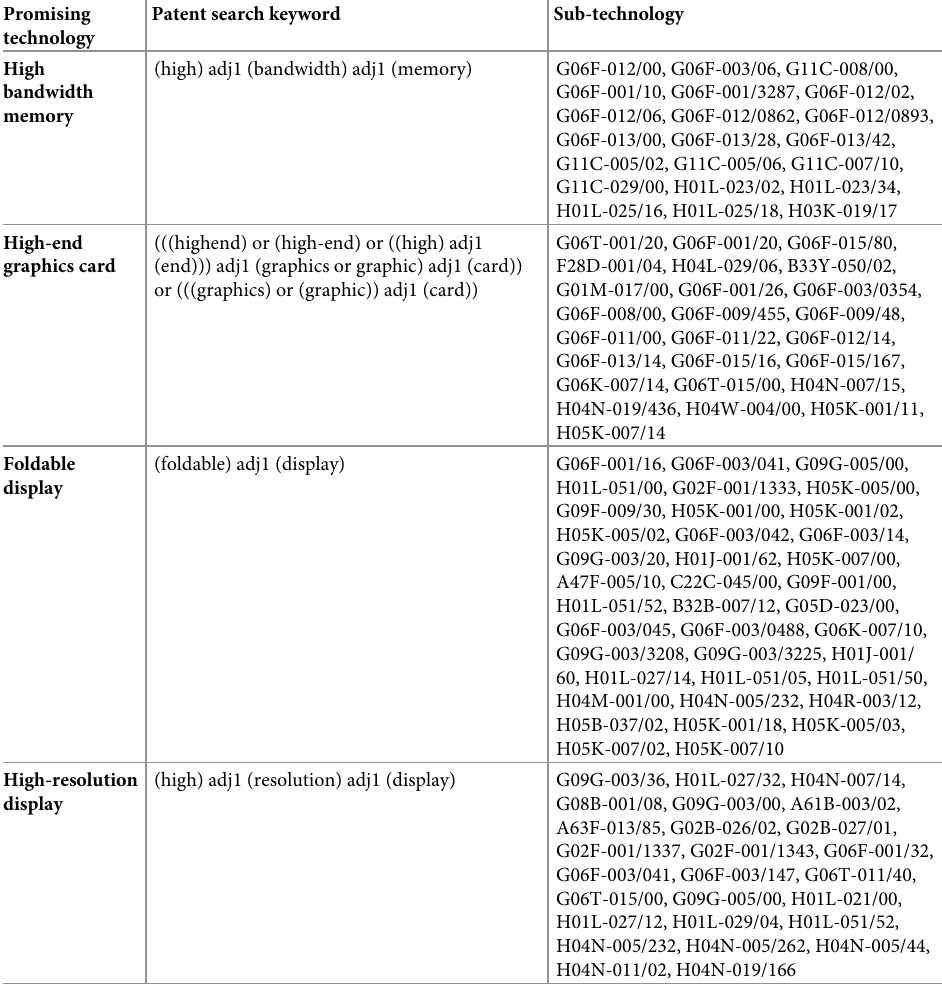
Table 2. Promising technologies and sub-technologies of SK Hynix Inc.